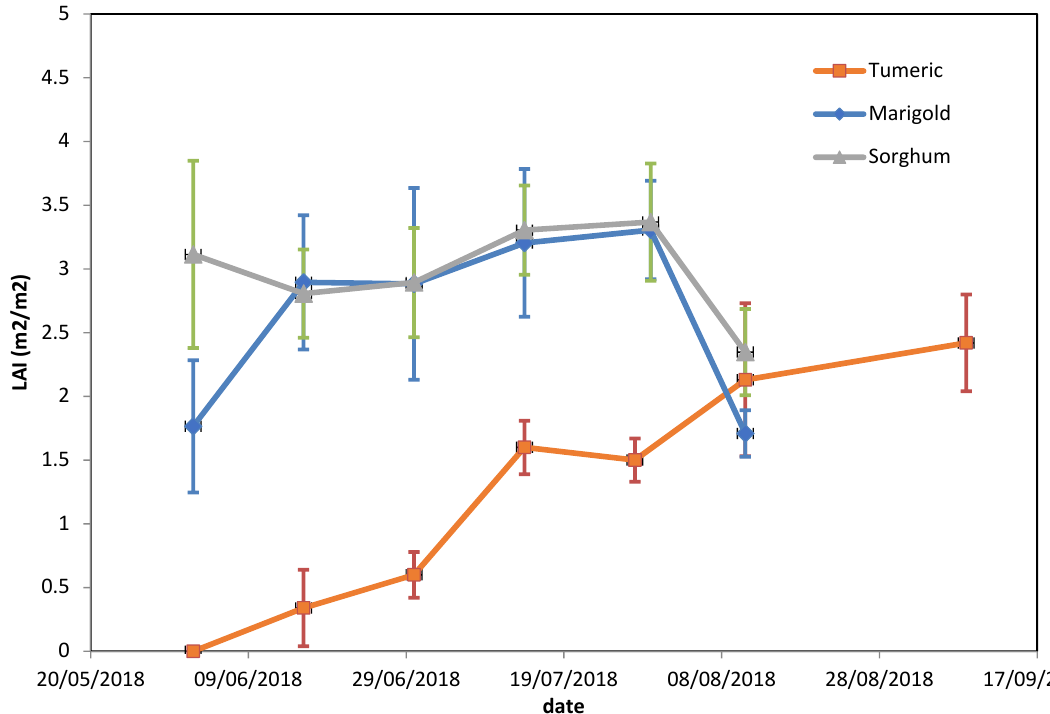
Figure 4. Ground measurements of leaf area index (LAI) in reference fields during the experimental campaigns.